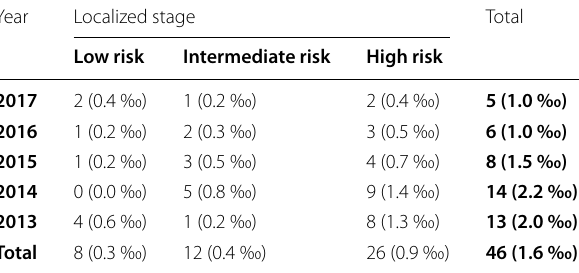
Table 3 Distribution of the total and annual incidence of cancer at the localized